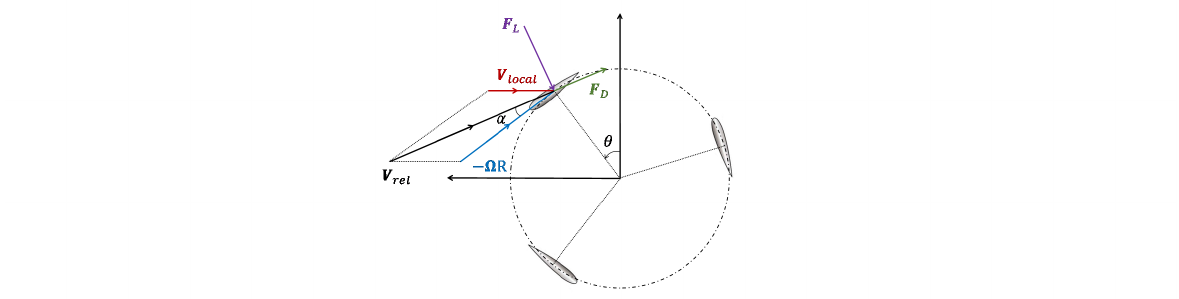
Figure 1. Schematic of a horizontal cross section of vertical-axis wind turbine (VAWT)